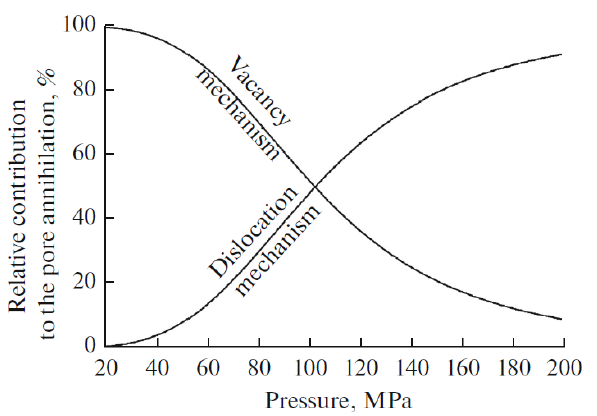
Figure 12. Change of relative contributions of vacancy and dislocation mechanisms to the pore annihilation during HIP with an increase in pressure [45] .